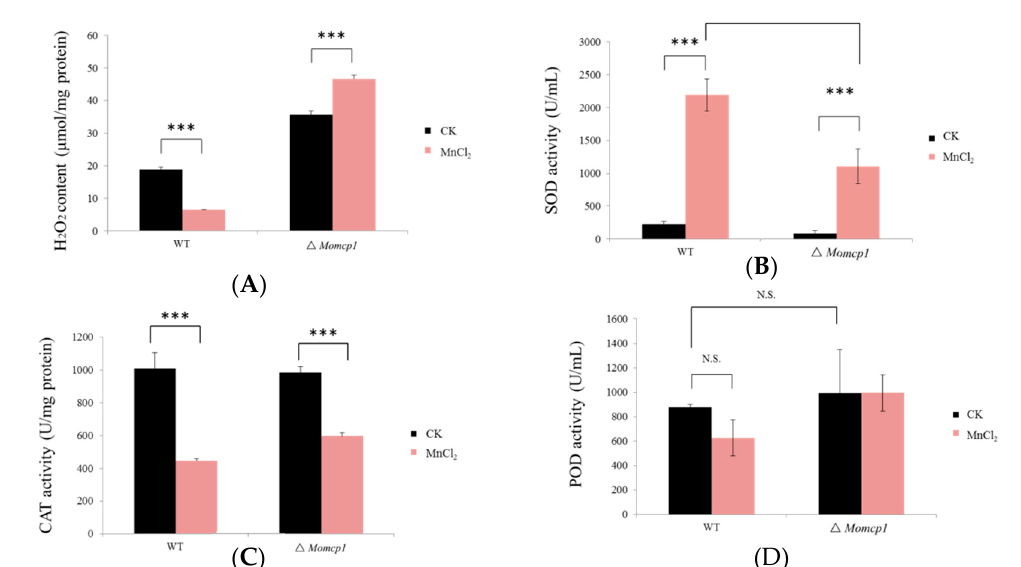
Figure 4. The changes of H 2 O 2 contents and activities of antioxidant enzymes in the WT and ∆ Momcp1 mutant under 2 mM Mn 2+ treatment. ( A ) H 2 O 2 contents. ( B ) SOD activity. ( C ) CAT activity. ( D ) POD activity. Each bar represents the means ± SD of three independent experiments. The significant differences were determined by Tukey-HSD test; ***, p < 0.001; N.S, no significance.